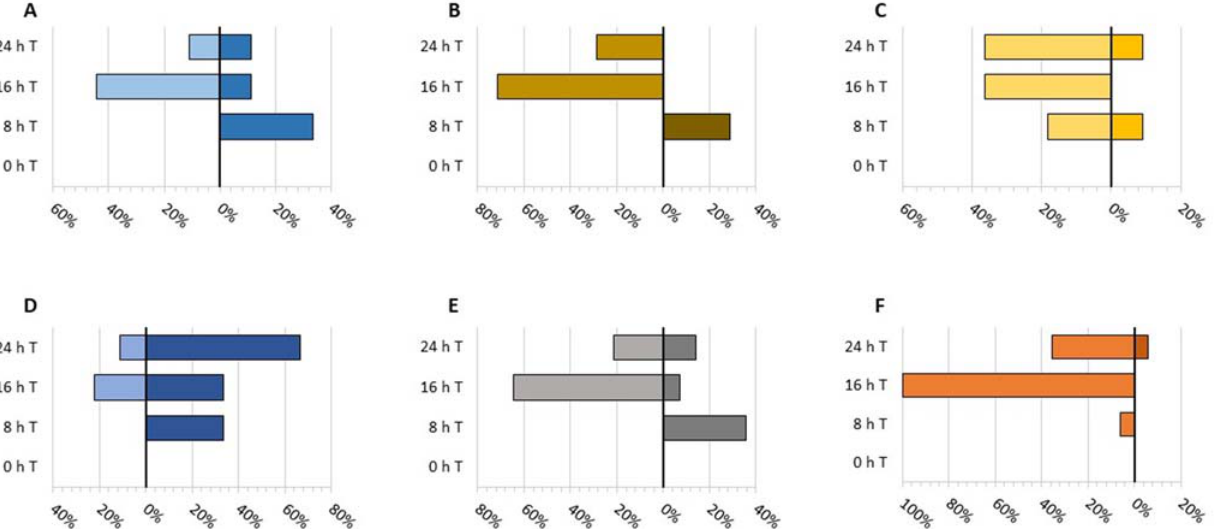
Figure 3. Stacked bar graphs of the adaption-related proteins for the determination of crucial time points following INAP treatment in N. tabacum cell suspensions. The graphs were created with respect to the prominent functional categories: ( A ) biosynthesis, ( B ) defence, ( C ) metabolism and energy, ( D ) response, ( E ) signalling and ( F ) transport. The percentages were determined through calculation of the number of either up- or down-regulated proteins relative to the number of proteins within the respective categories. Values to the left of zero (0) indicate down-regulation while those to the right depict up ‐ regulation. The colour code is as for Figure 2.